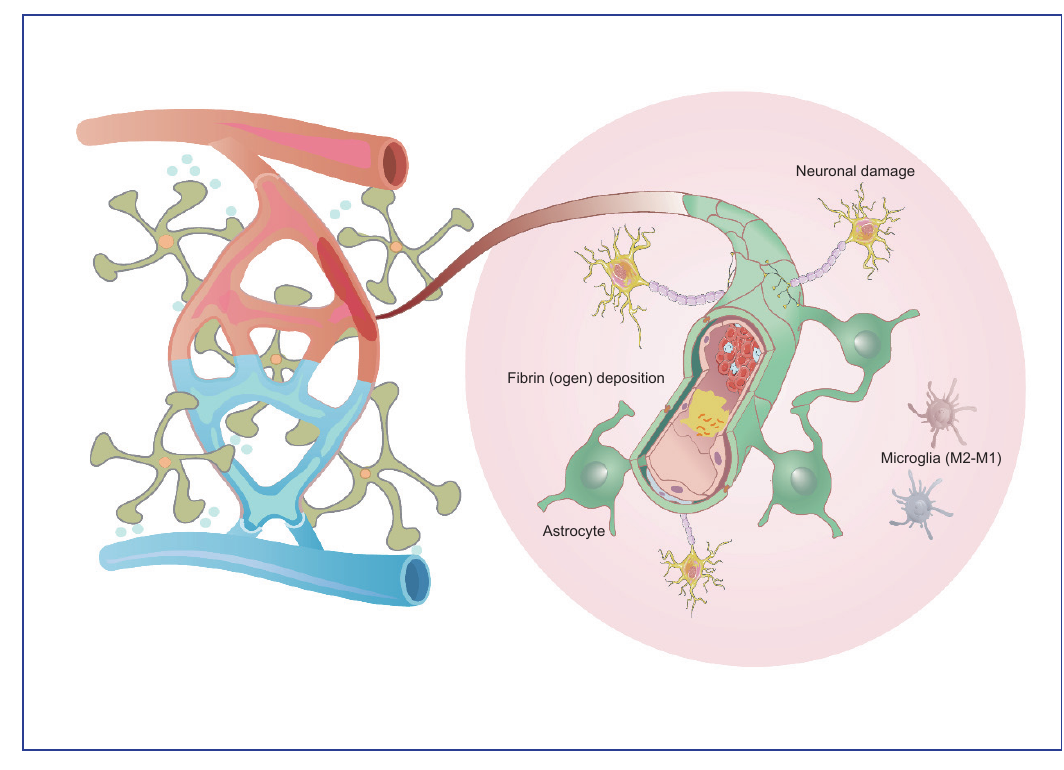
Figure 1 Pathological changes in components of a single neurovascular unit after stroke. The cerebral microcirculatory system and neural network are intertwined in three-dimensional topological space to form a "vine-like" structure. At the embolic site, local ischemia leads to the deposition of toxic fibrinogen in the vascular lumen, the swelling of astrocytic endfeet, and the activation of proinflammatory (M1-type) microglia induced by damage to adjacent neurons. The resulting proinflammatory reactions further aggravate neuronal dysfunction and expansion of the infarct area.